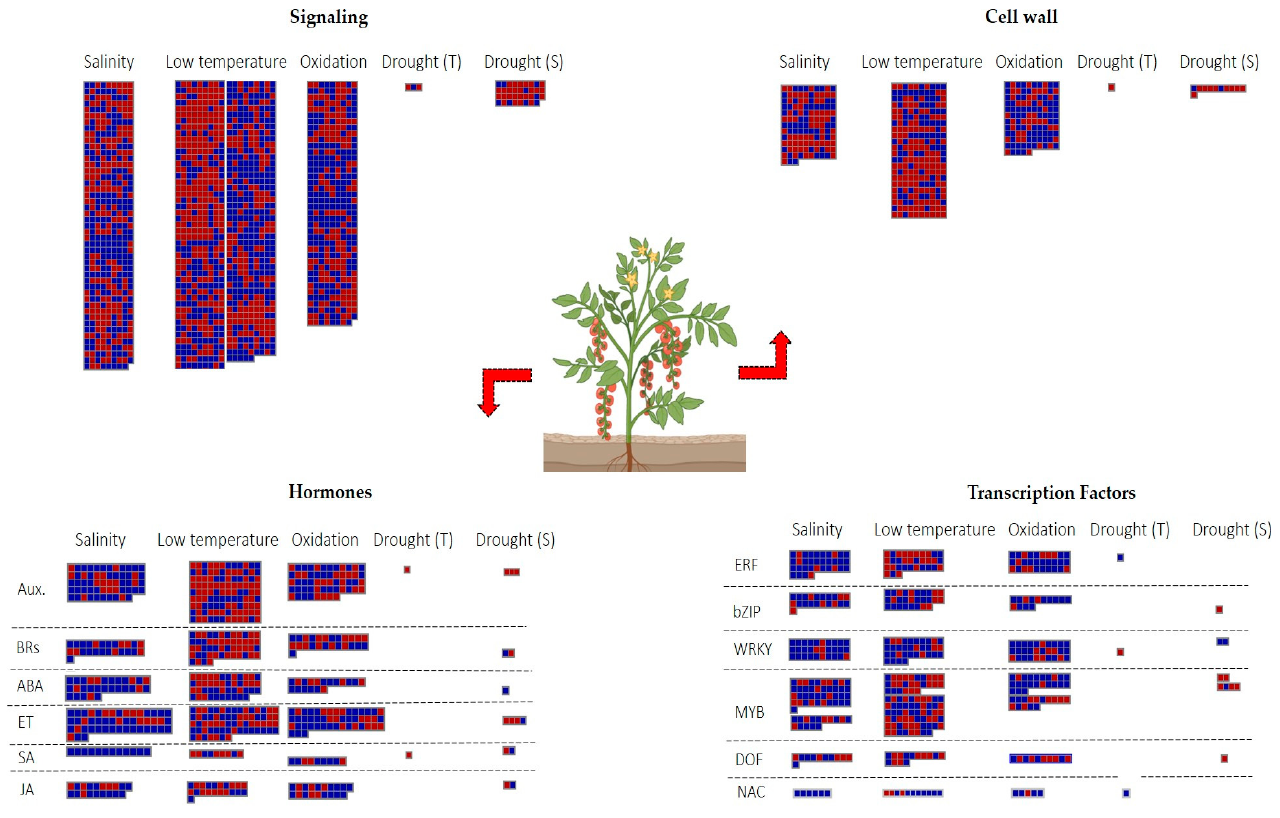
Figure 7. DEGs involved in signaling, cell wall, hormones, and TFs. Blue = upregulated; red = downregulated genes. Table 2. Genes identified as responsive to different abiotic stress and involved in signaling and cell wall-related